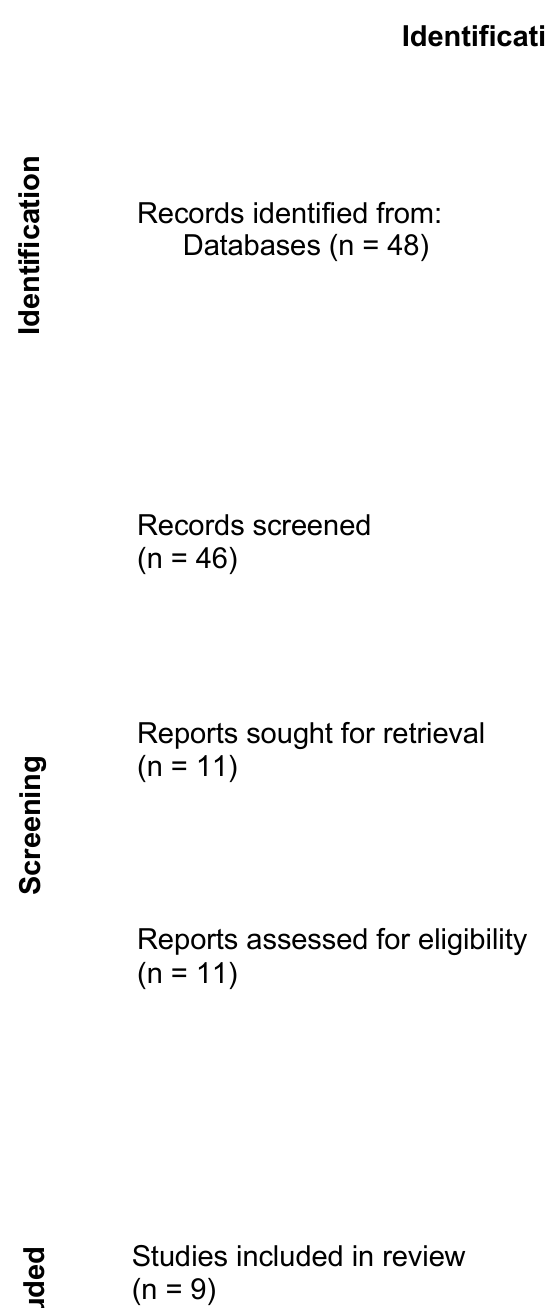
Figure 1. Flow diagram for the study selection process .